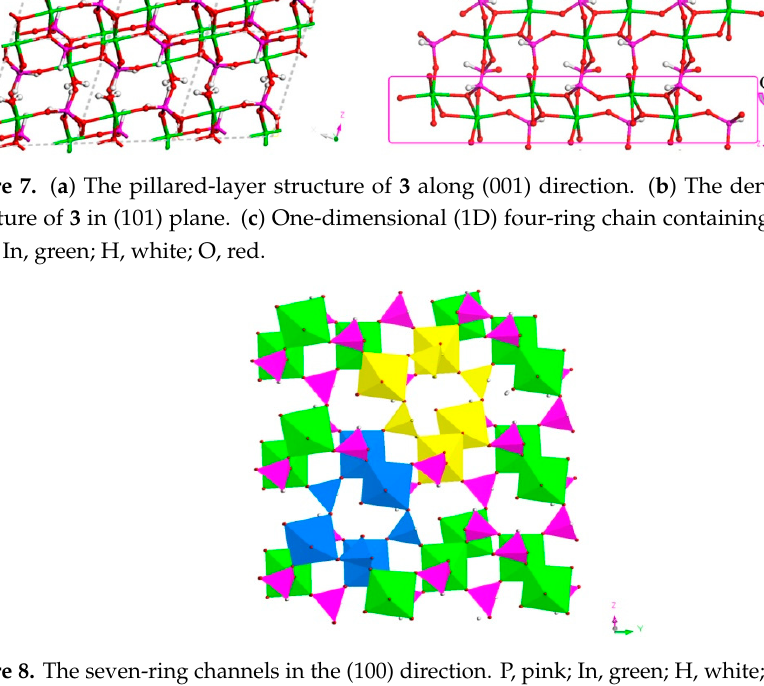
Figure 8. The seven-ring channels in the (100) direction. P, pink; In, green; H, white; O, red; seven-ring channels, yellow and blue.